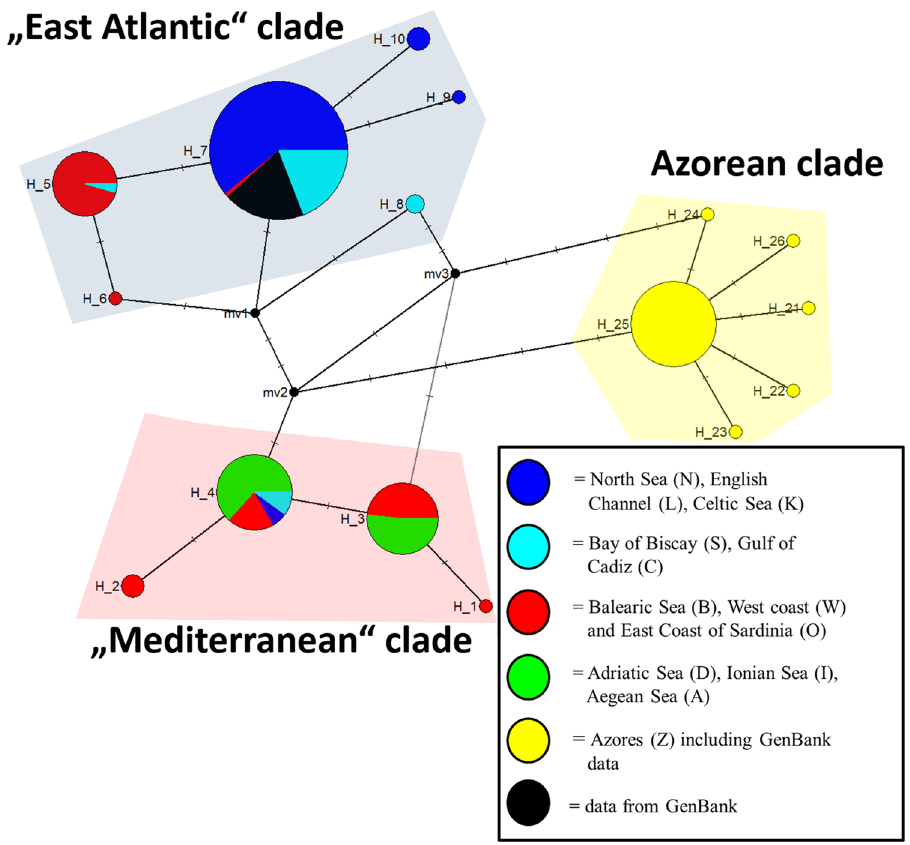
Figure 3. Haplotype network after Median-Joining Method for L. forbesii (haplotypes 1–10, 21–26) representing 249 COI-sequences (561 bp); black coloured GenBank data 33–37 by various authors originate all from North East Atlantic individuals, yellow coloured including GenBank data 38–40 .